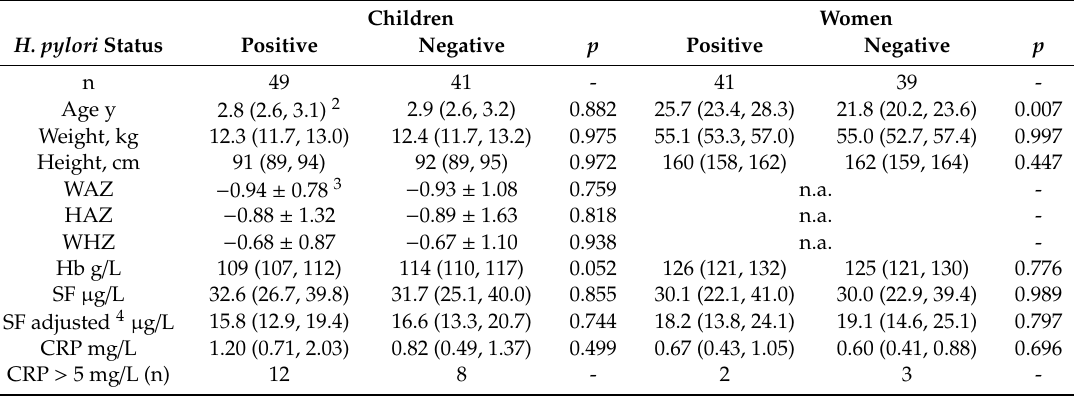
Table 2. Subject characteristics: Age, anthropometrics, hemoglobin (Hb), serum ferritin (SF), and C-reactive protein (CRP) concentrations, of all subjects grouped by H. pylori infection status and age group 1